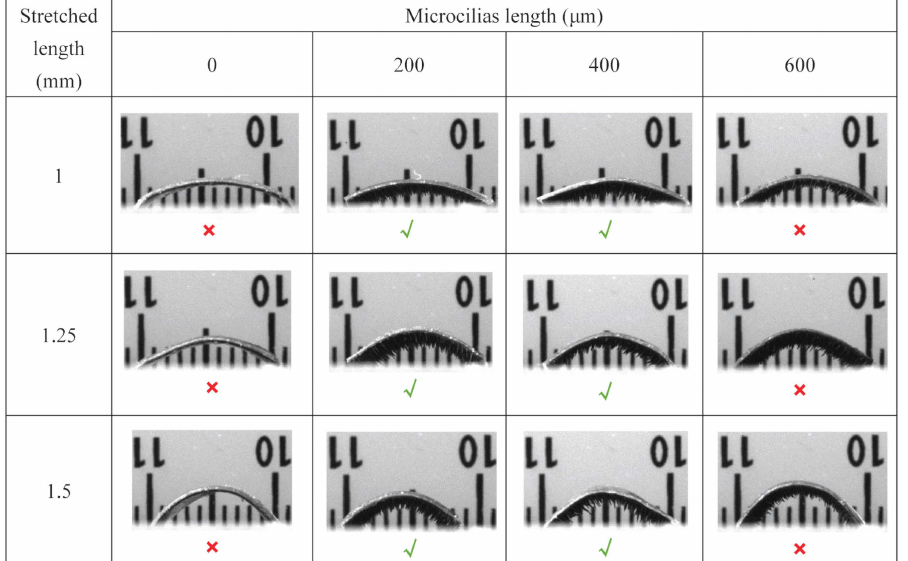
Figure 3. Performance evaluations of magnetic inchworm robots for combinations with stretched length set and micropillar length set. (cid:36) means that the magnetic inchworm robot cannot move like a biological inchworm, and (cid:34) indicates that the inchworm robot can move like a biological inchworm crawling